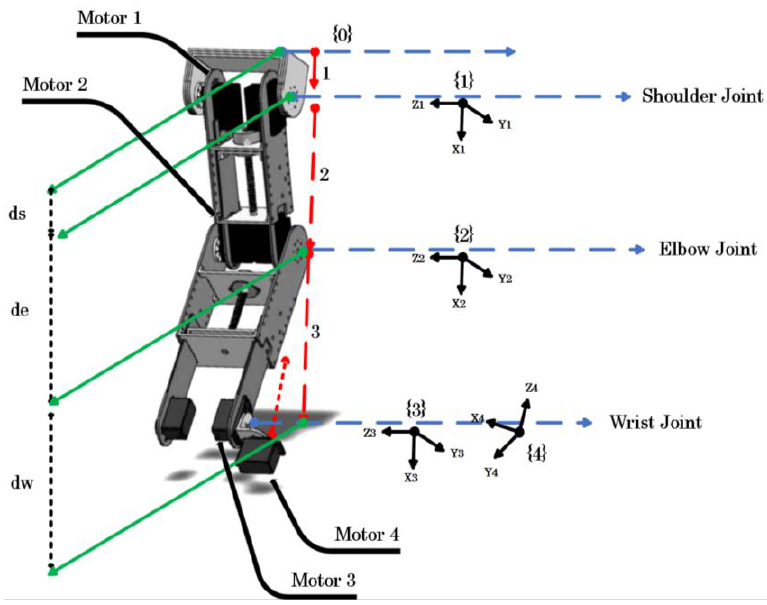
Figure 3. Robot kinematics. Table 2. Movements of the exoskeleton robot.